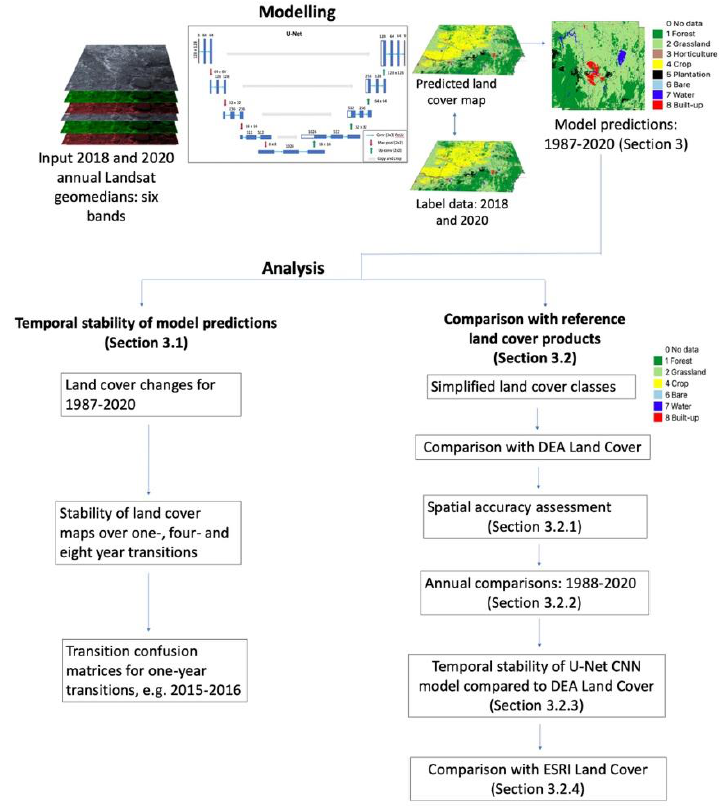
Figure 2. Modelling and analysis workflow of study. Table 1. Dataset splits used for model development. Test set from tile +14, − 40 (Figure 1). Dataset